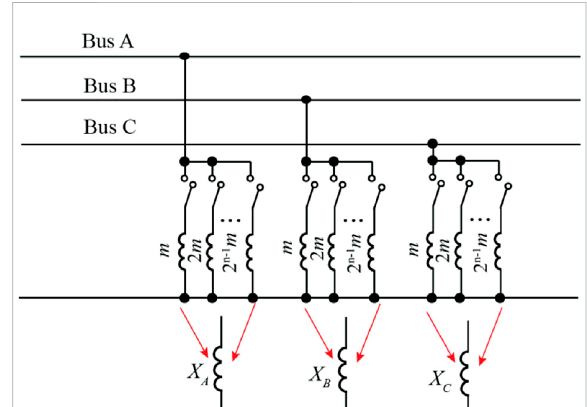
FIGURE 2 Schematic diagram of the equivalent test system.